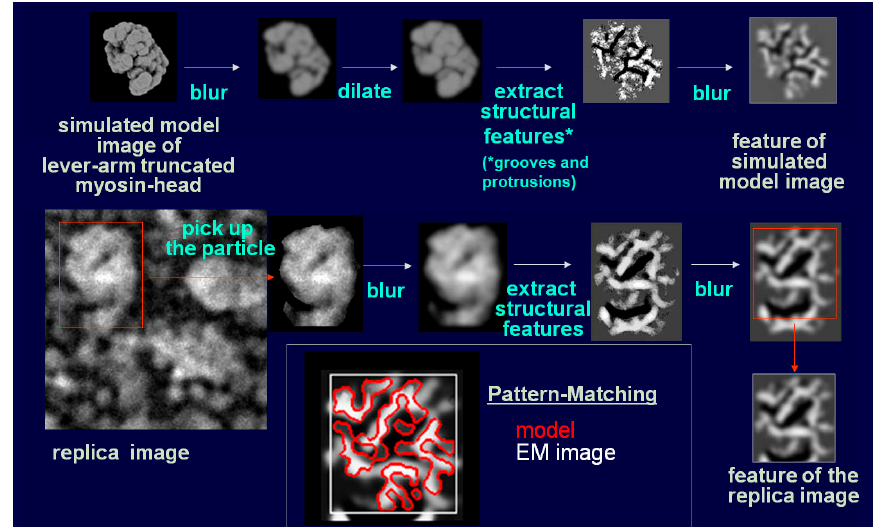
Figure 2. Flow-diagram exhibiting the standard pattern-matching procedure by correlation between freeze-replica images of the lever arm truncated myosin head (S1) and simulated model images [31]. Note the nice matching of the patterns extracted from replica image (grayscale) and simulated image (red).